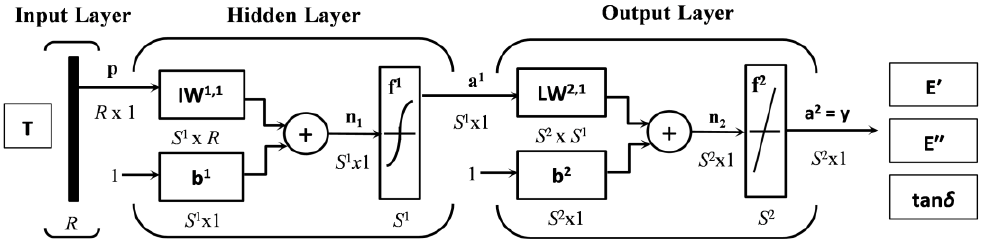
Figure 2. Schematic of the artificial neural networks (ANN) architecture for modeling the temperature dependencies of the storage modulus E′ ( T ), loss modulus E′′ ( T ) and damping factor tan δ( T ) of the investigated TPU at a given constant frequency of its dynamic mechanical loading.